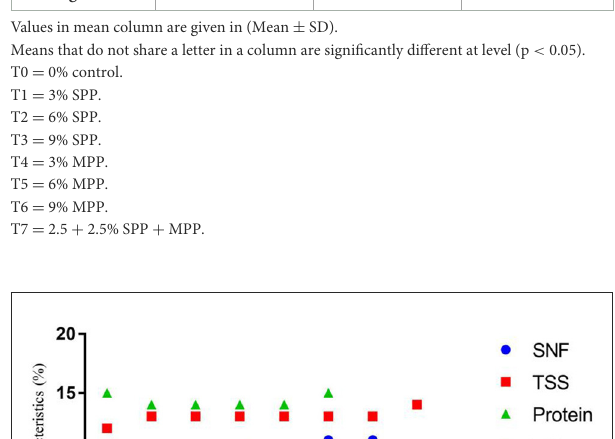
TABLE 5 Bioactive profile of SPP and MPP.